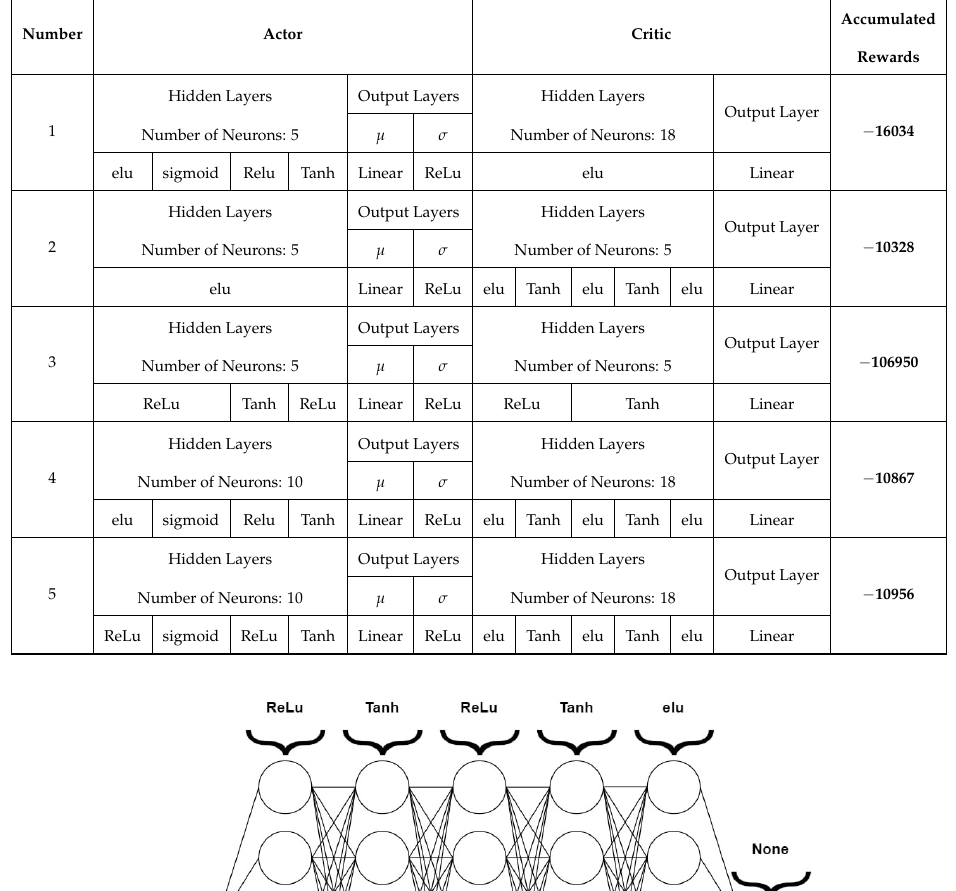
Table 3. Various actor-critic models.